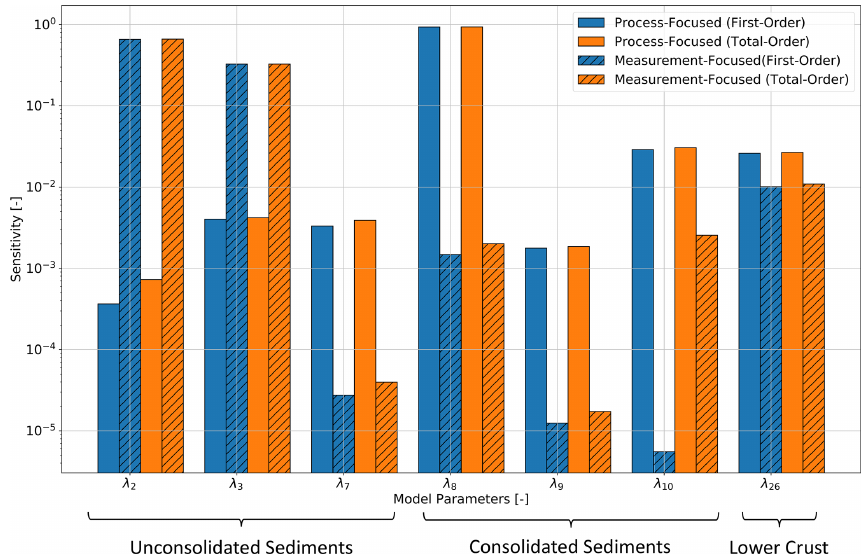
Figure 8. Sensitivity analysis of the unconsolidated and consolidated sediments with different quantities of interest of the hierarchical global sensitivity analysis for the General-Focus Alps model. For the layer IDs and symbols, please refer to Table A1.